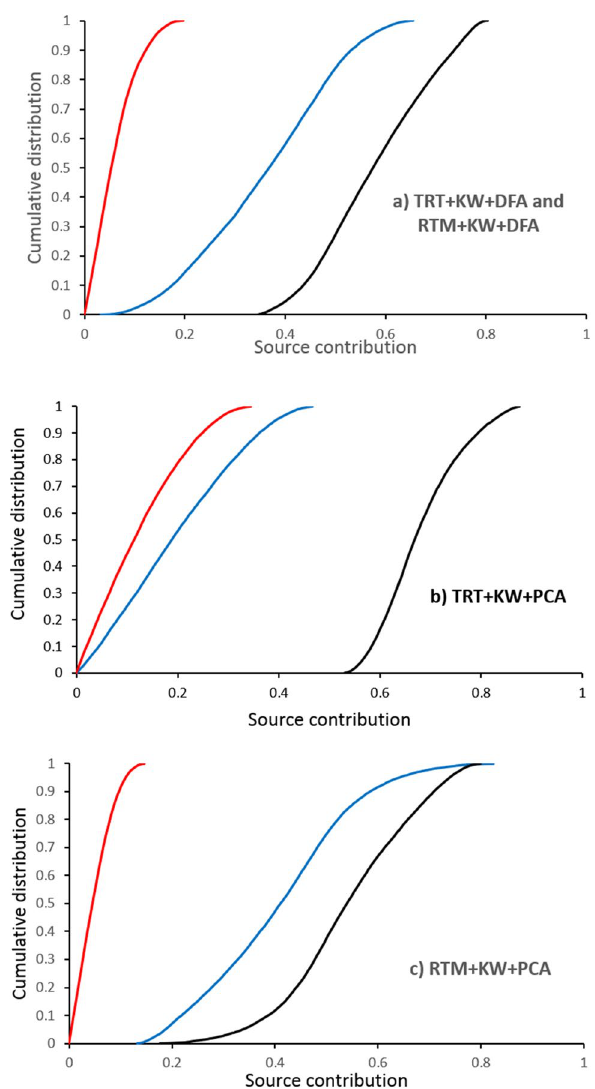
Figure 9. The cumulative distributions for the overall mean contributions of the three sub-basin spatial sediment sources (western sub-basin—blue line, central sub-basin—red line and eastern sub-basin—black line) modelled using GLUE with the different combinations of the statistical